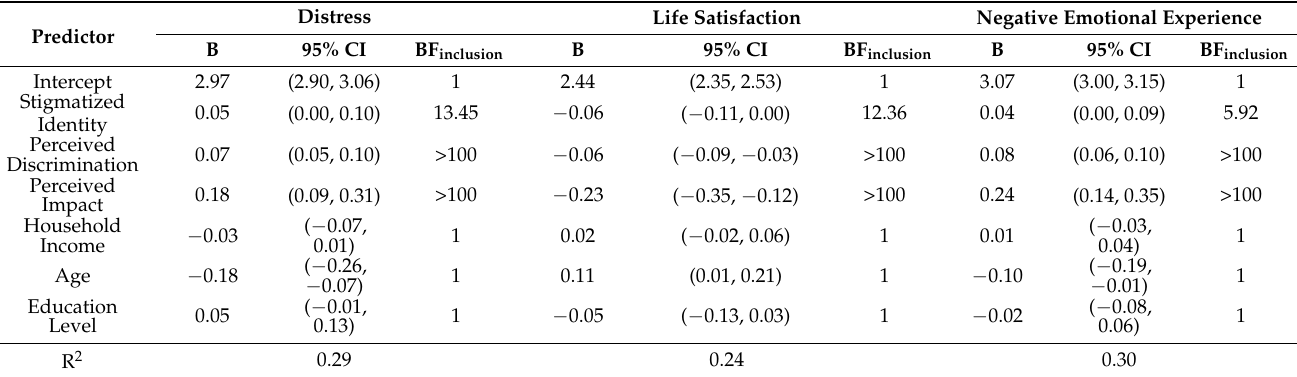
Table 4. Multiple regression models predicting distress, life satisfaction and negative emotional